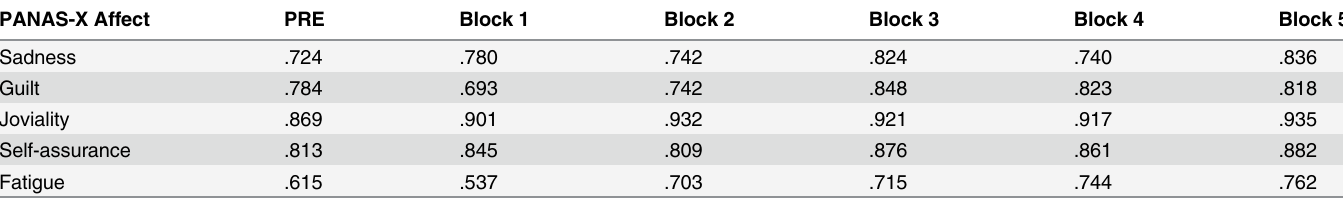
Table 2. Reliability (Cronbach ’ s alpha) of the PANAS-X affect scales administered at the beginning of Study 2 (PRE) and at the end of the five blocks. PANAS-X Affect